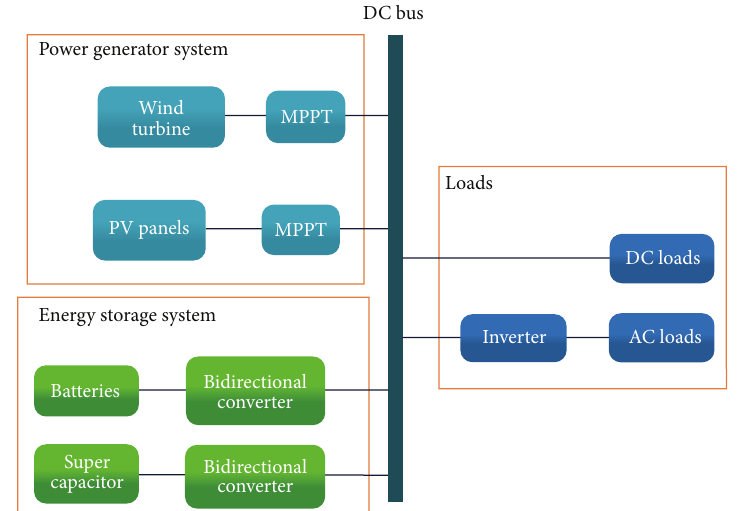
Figure 1: Hybrid power system structure.